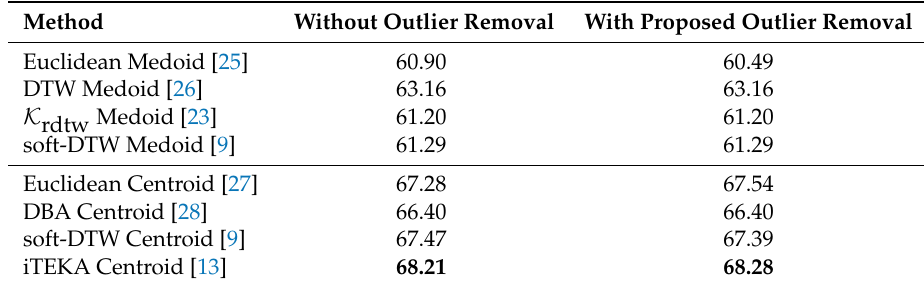
Table 1. Best HC-SIM (in %) obtained with or without outlier removal for the eight tested methods. The best obtained HC-SIM value are indicated in bold